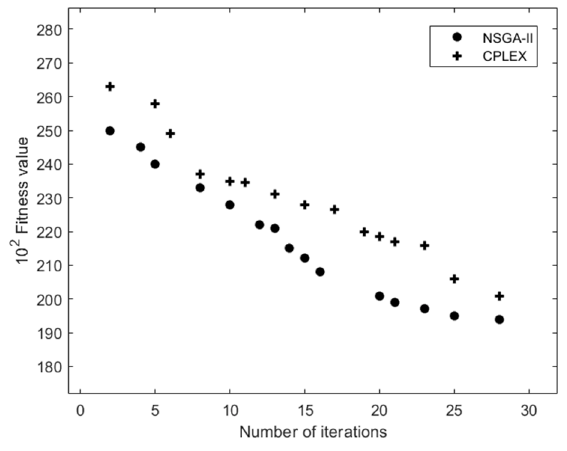
Figure 4. Iterative graph of fitness values under scenario 1.